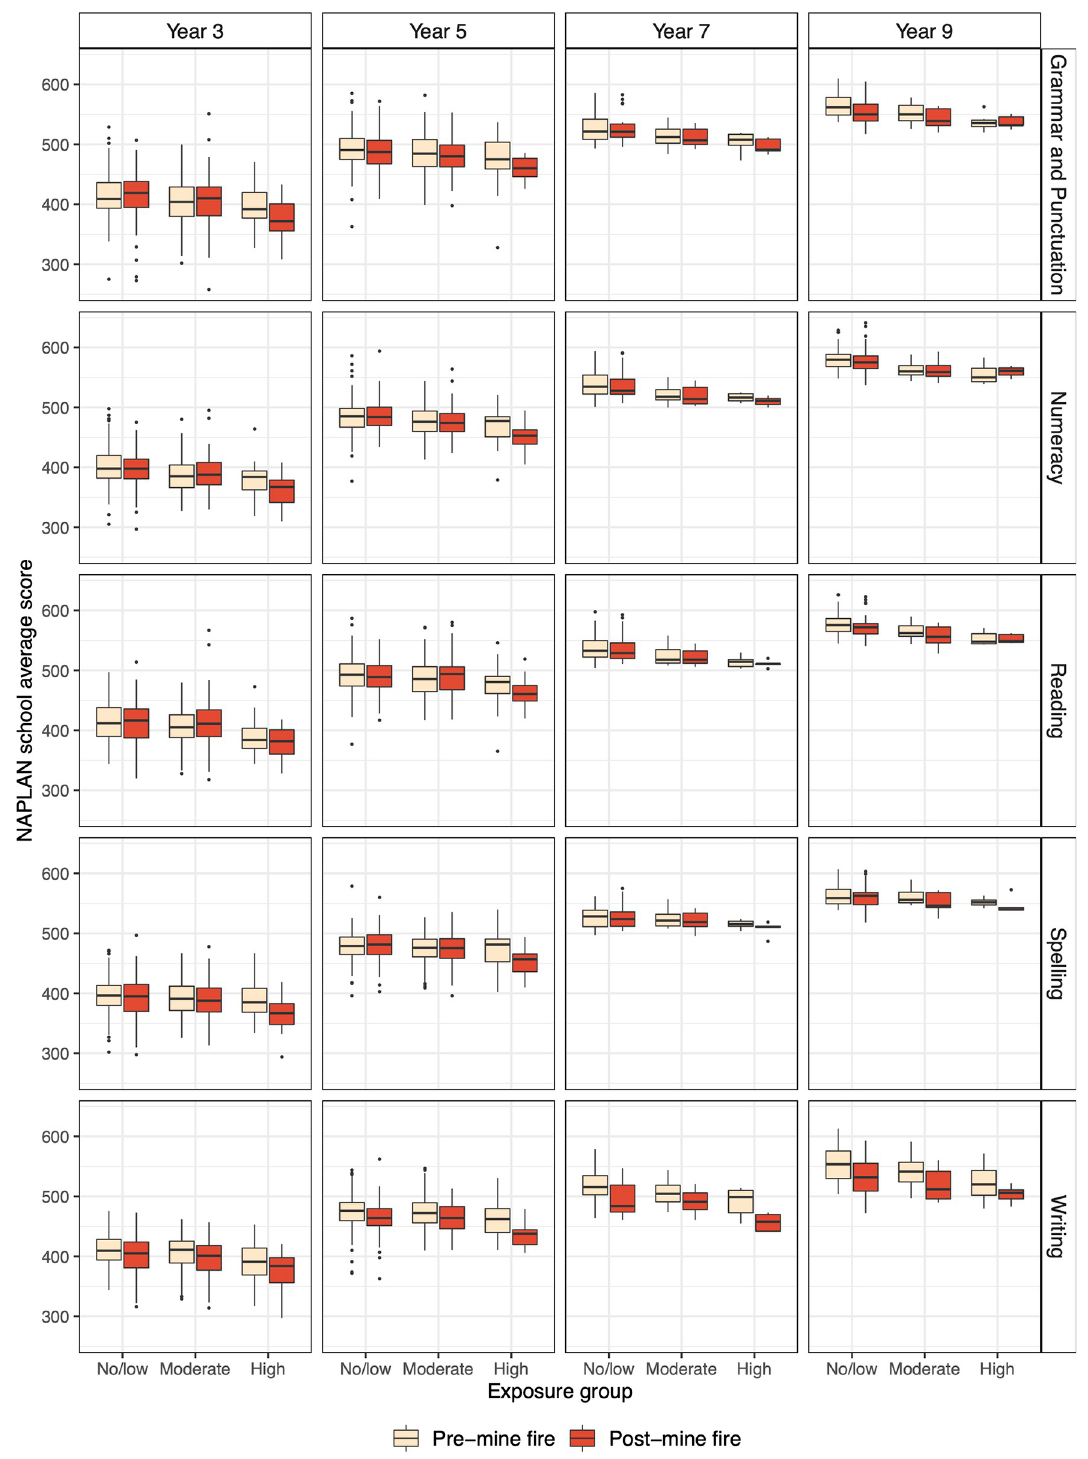
Fig 3. Box plot of school mean NAPLAN score for pre-mine fire period and post-mine fire period by exposure group for each domain and grade level.